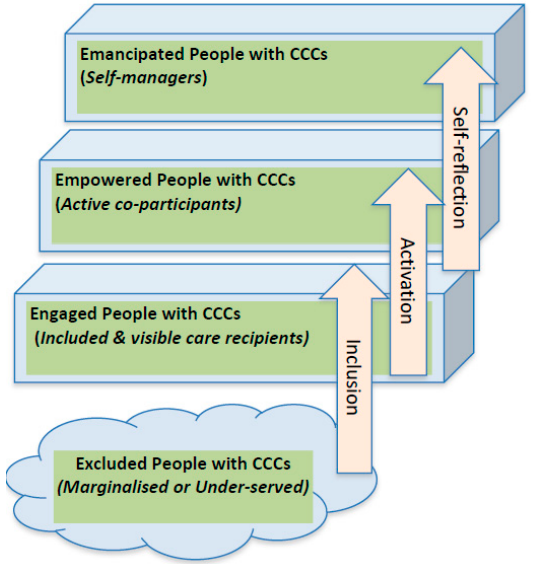
Figure 1. Locating People Living with CCCs in the trajectory of health transitions.